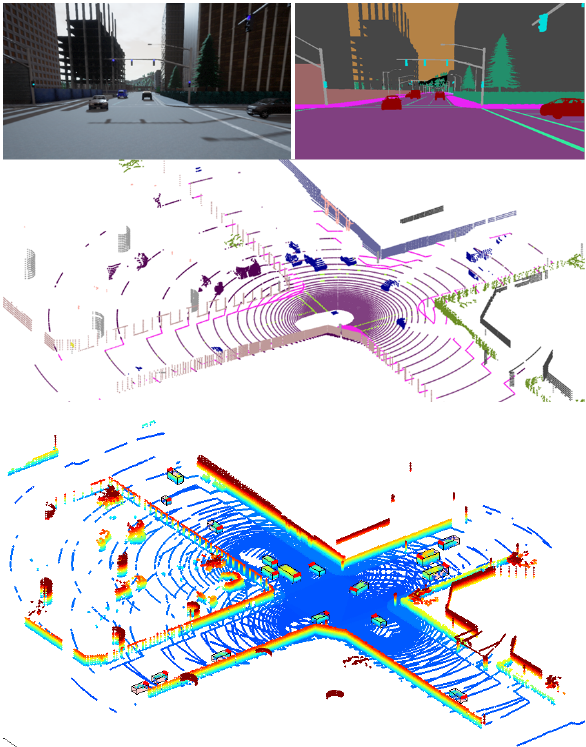
Figure 3. An example frame of the data collected by a single vehicle. Top left: RGB image; Top right: semantic segmentation label; Middle: point cloud colored by the point-wise label; Bot- tom: Fused point cloud data from 5 vehicles and the ground truth bounding boxes of all vehicles in the scene (height information is encoded into the point color, lines of bounding boxes are in black, the direction of bounding boxes are illustrated with a red bar on the upper front line of each box) much redundant data. These selected vehicles are colored in